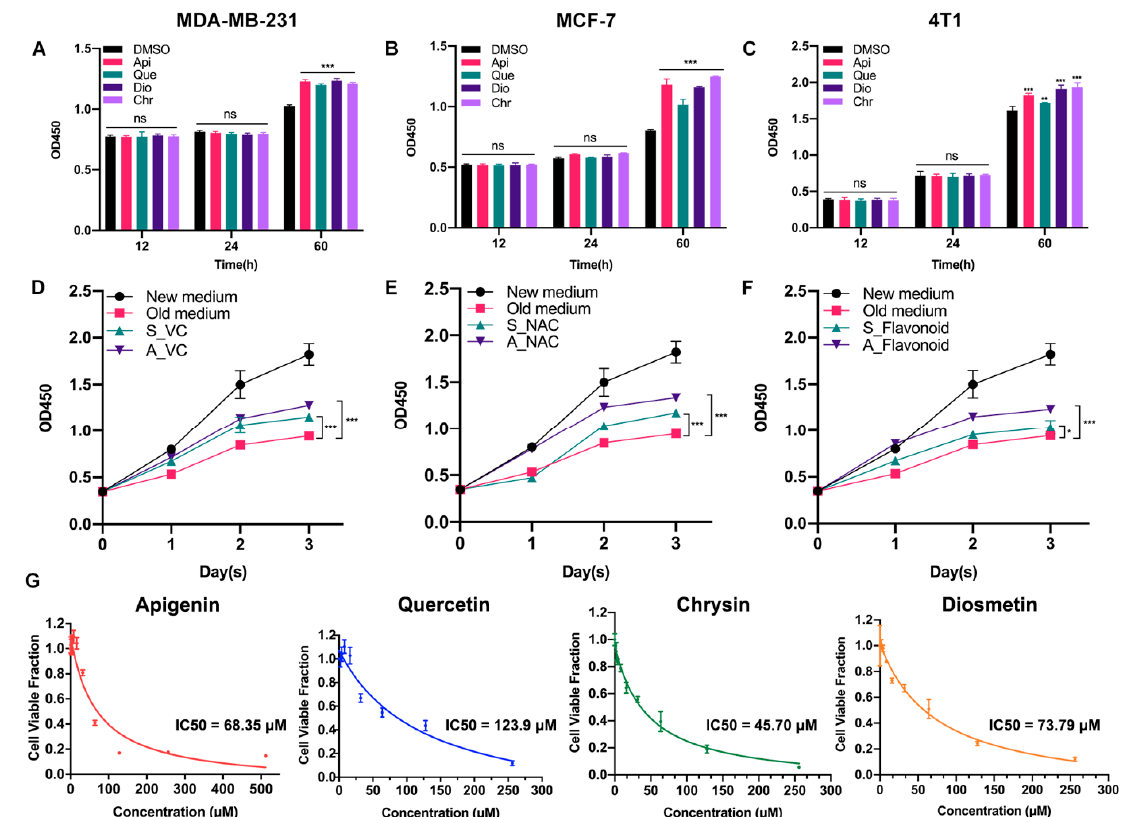
Figure 1. Low-dose flavonoids promoted cell growth by reducing oxidative reactions under long- term treatment. ( A ) The cell number of MDA-MB-231 treated with DMSO or flavonoids under 12, 24 or 60 h was detected. ( B ) The cell number of MCF-7 treated with DMSO or flavonoids under 12, 24 or 60 h was detected. ( C ) The cell number of 4T1 treated with DMSO or flavonoids under 12, 24 or 60 h was detected. ( D ) The growth rate of four groups. New medium: culturing the new seeded cells with fresh medium; Old medium: culturing the new seeded cells with old medium that had already cultured MCF-7 cells for 48 h. A_VC: culturing the new seeded cells with the above old medium but with VC supplement. S_VC: culturing the new seeded cells with collected medium in which VC had been simultaneously added for 48 h cotreatment in MCF-7 cells. VC: 500 µM. ( E ) The growth rate of four groups. The treatment was similar to ( D ). NAC: 5 µM. ( F ) The growth rate of four groups. The treatment was similar to ( D ). Flavonoid: apigenin, 5 µM. ( G ) The IC 50 of four flavonoids was detected in MCF-7 cells. Data was shown as the mean ± SD. * p < 0.05, ** p < 0.01, *** p < 0.001. ns indicates no significant difference.